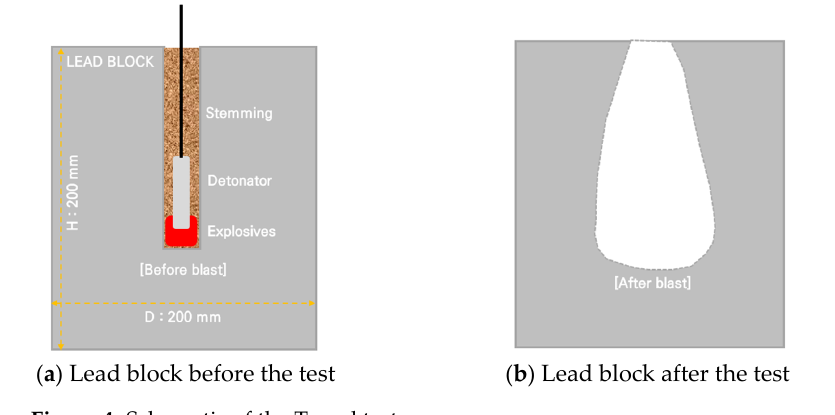
Figure 4. Schematic of the Trauzl